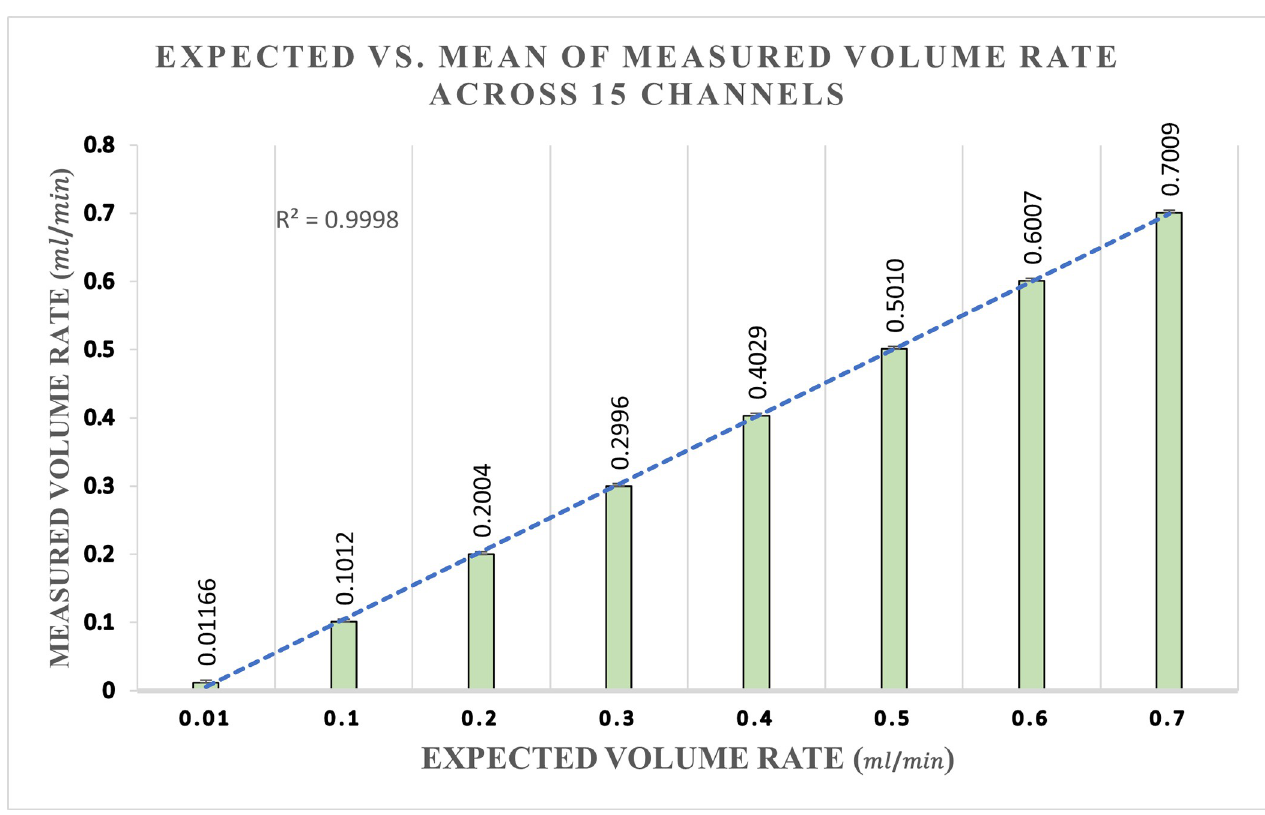
Fig 3. Expected vs. measured over 0.01 to 0.7 ml a